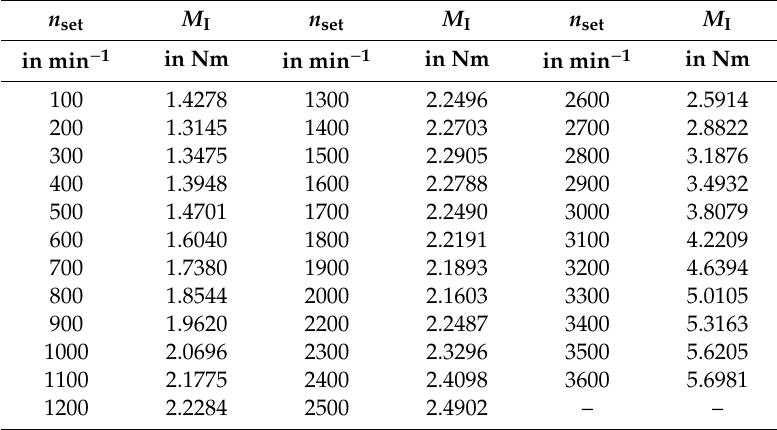
Table A2. Idling torque M I depending on the set RPM-rate n set . n